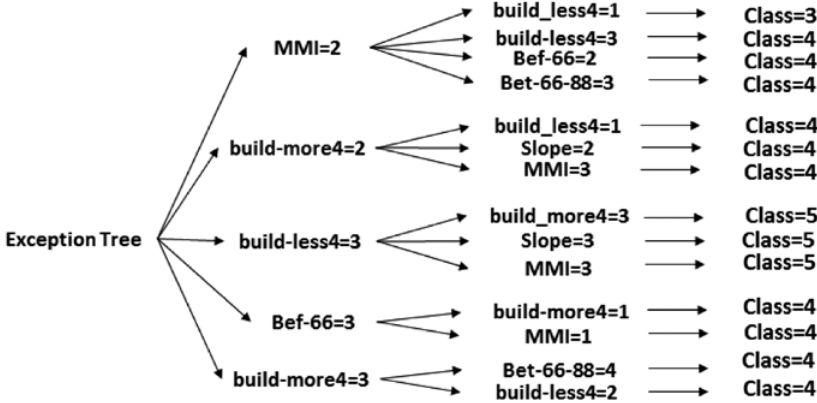
Fig. 3. Granule tree for extracting exception